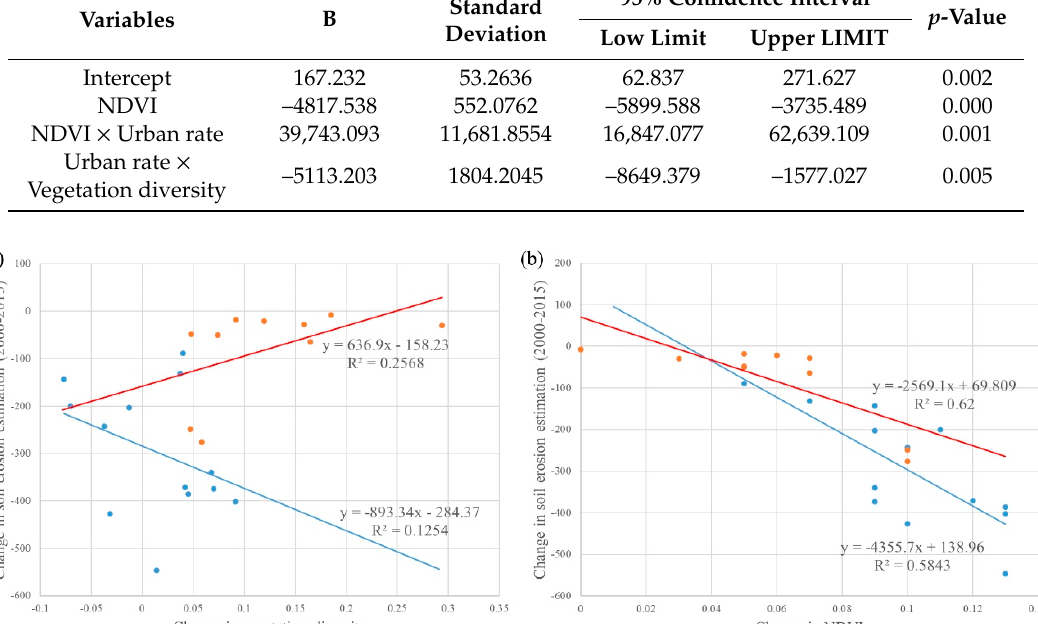
Figure 9. Effects of the interaction ( a ) between urbanisation and vegetation diversity and ( b ) between urbanisation and NDVI on soil erosion risk. The blue and red lines indicate that the increase in urbanisation rate was lower and higher than 0.1, respectively.